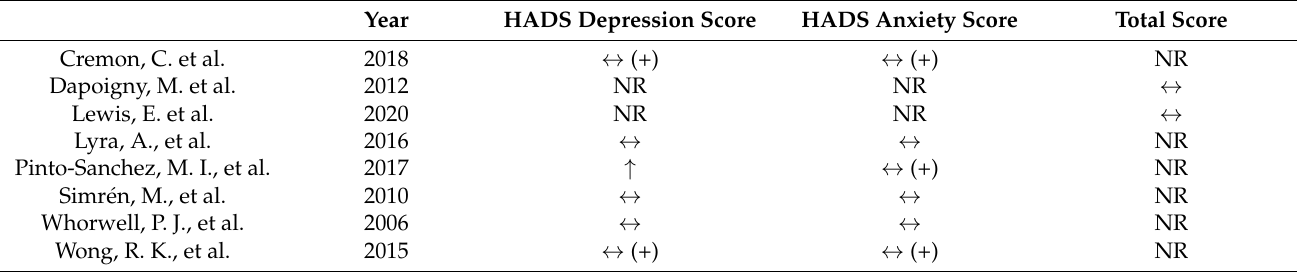
Table 3. Changes of symptoms for depression and anxiety compared between probiotic versus placebo intervention; HADS = Hospital Anxiety and Depression Scale. ↑ : symptom improvement p < 0.05 in probiotic versus placebo group; ↓ : symptom deterioration p < 0.05 in probiotic versus placebo group; ↔ : no group differences and no trend; ↔ (+): no group differences (trend towards symptom improvement); NR: not reported .